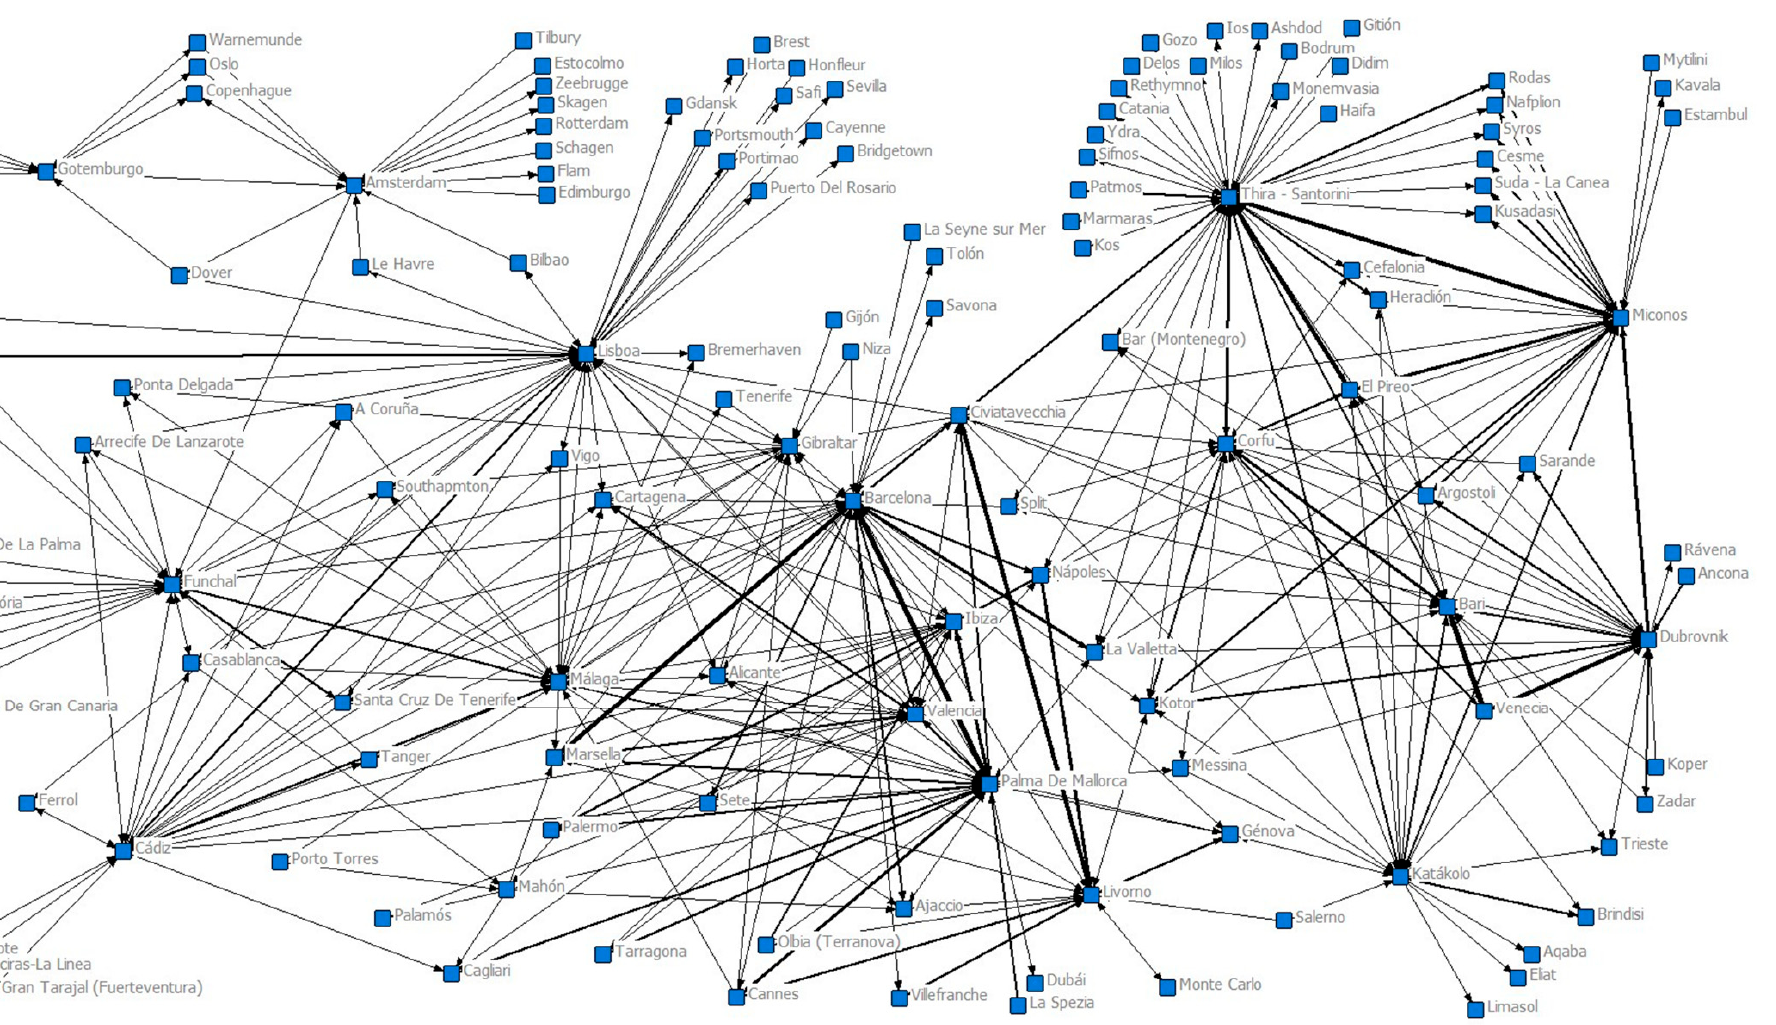
Figure 7. Interrelations in contemporary cruise port network in Southern Europe in 2019. Source: Authors elaboration. Note: The thickness of the lines indicates the traffic intensity between ports.